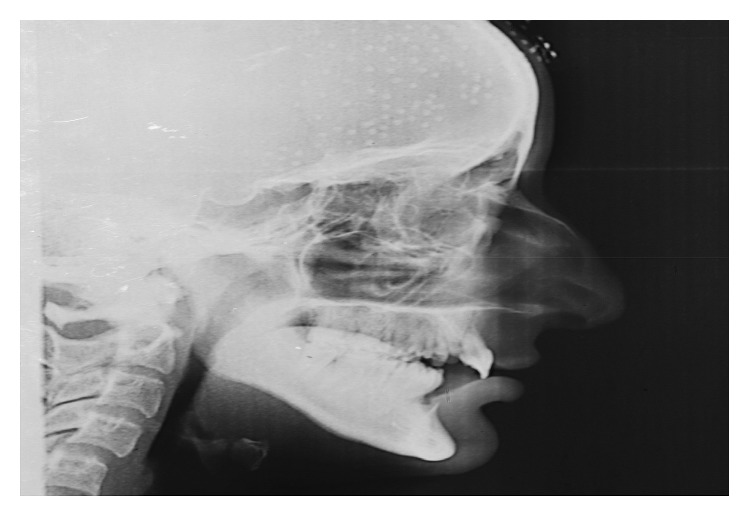
Lateral cephalogram.